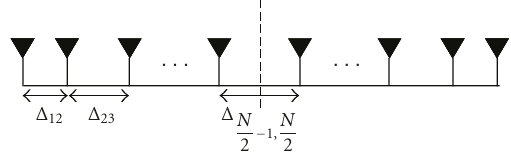
Figure 2: Nonuniform symmetric array structure for N